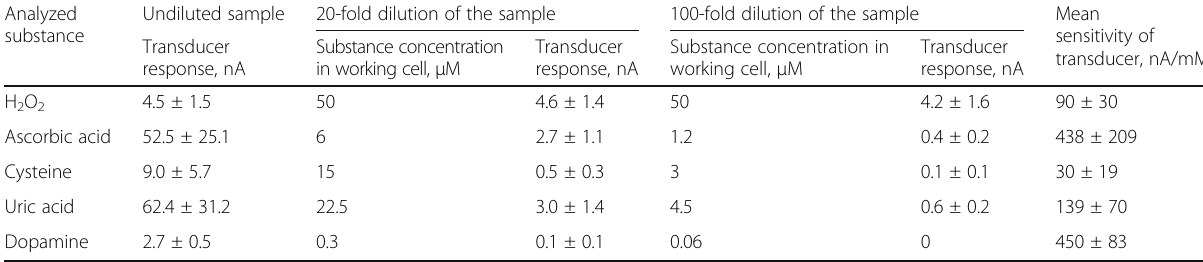
Table 2 Responses and sensitivity of platinum disk transducer to electroactive materials. Responses are received in 10 mM HEPES buffer, pH